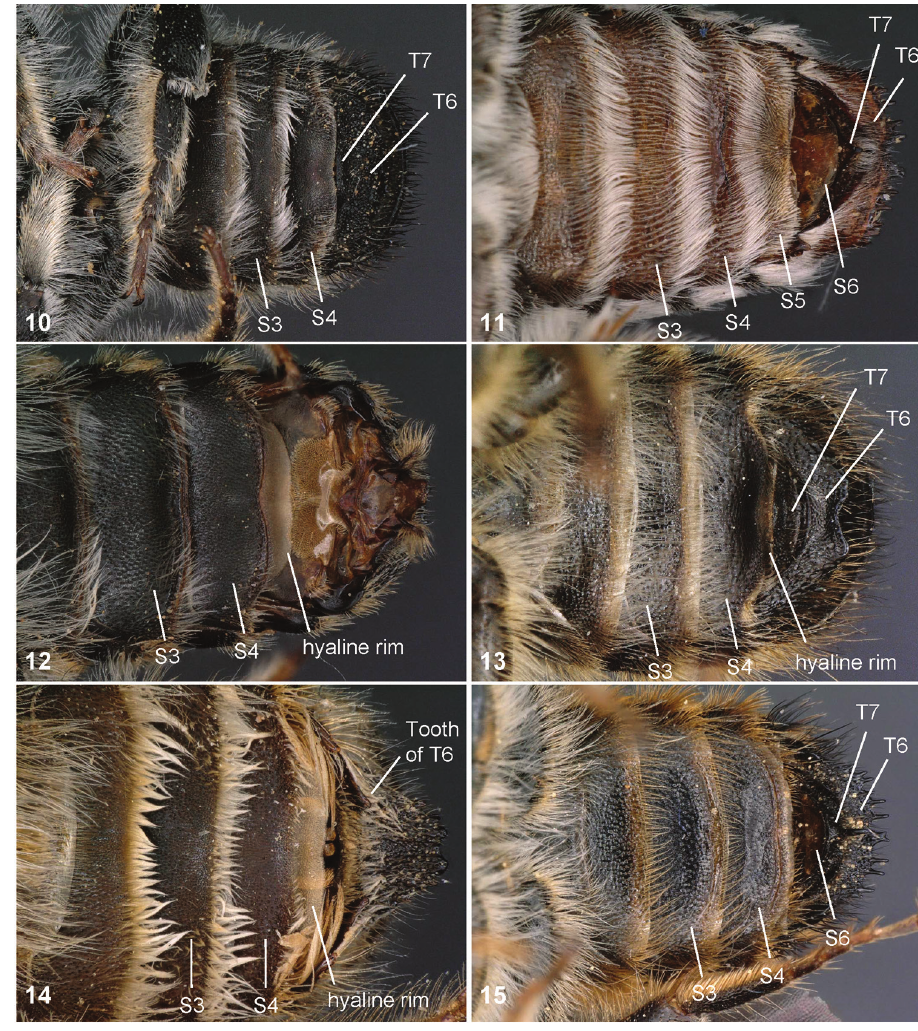
Figures 10–15. Male metasoma, ventral view. 10 Megachile ( Eutricharaea ) giraudi , metasoma with four exposed sterna, S4 without hyaline rim, T7 small, unmodified 11 M. ( Creightonella ) amabilis , metasoma with six exposed sterna, S6 with rounded, weakly sclerotized projection 12 M. ( Anodonteutricharaea ) sp. aff. inornata , metasoma with four exposed sterna, S4 with apical, hyaline rim (note that S5-S8 are visible in this specimen because the metasoma has been stretched) 13 M. ( Megachile ) ligniseca , condition as in Fig. 12 14 M. ( Eurymella ) patellimana , condition as in Fig. 12 15 M. ( Chalicodoma ) montenegrensis , S6 partly exposed, with rounded, weakly sclerotized